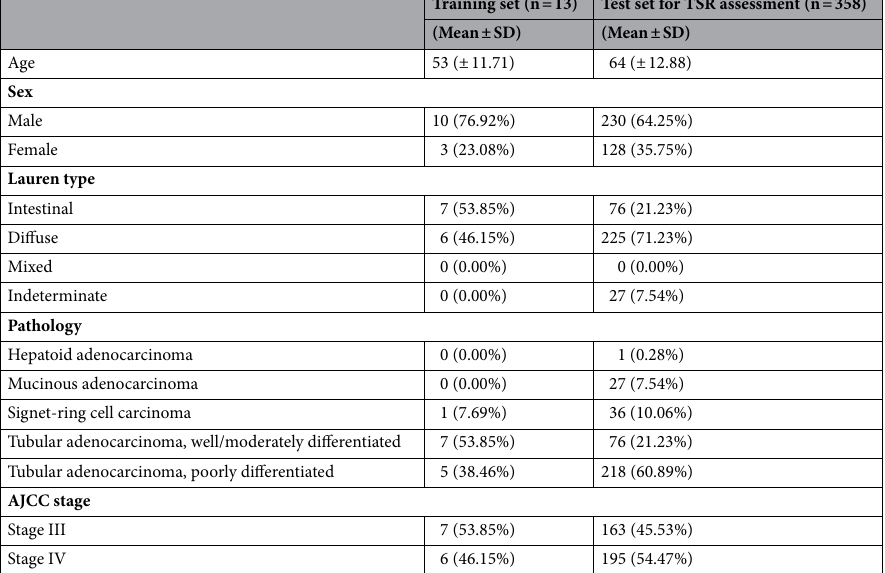
Table 1. Clinicopathologic characteristics of patients with gastric adenocarcinoma. SD standard